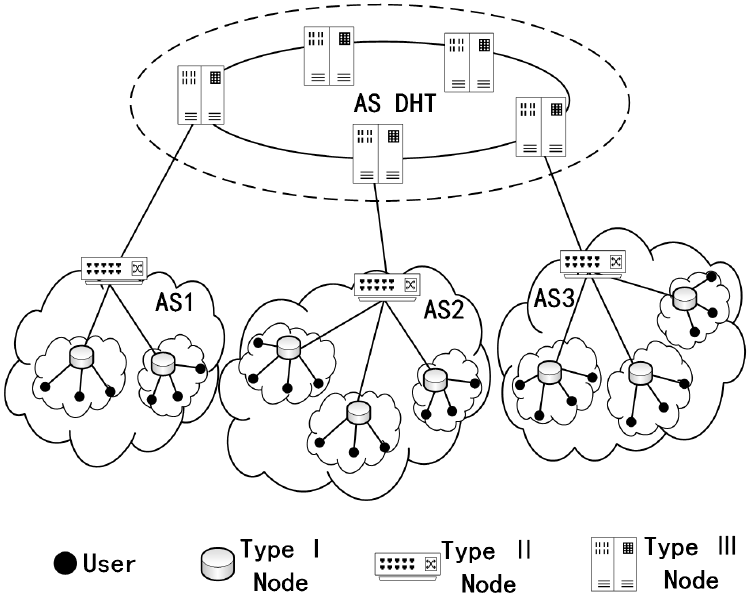
Figure 3. System